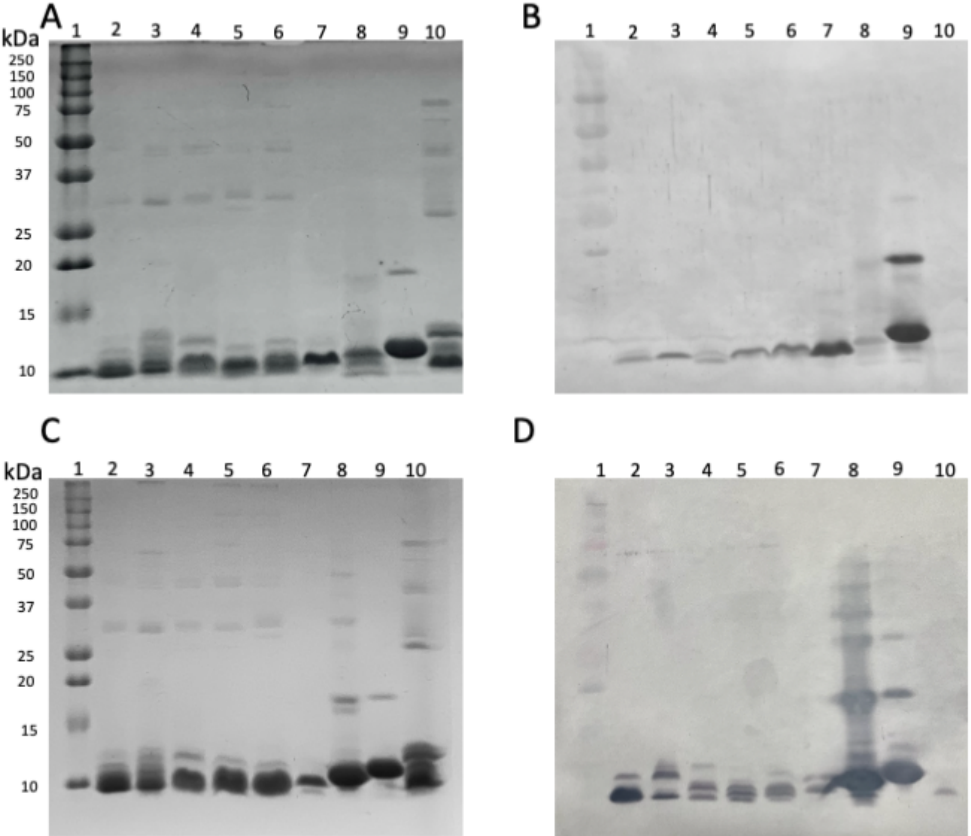
Figure 4. Proteins contained in venoms from different species of North Africa and the Middle East scorpion venoms were detected by SDS-PAGE and Western-blot. (A) SDS-PAGE 12.5%, (B) Western blot anti-HisrAcra4, (C) SDS-PAGE 12.5%, (D) Western blot anti-Scctx. Lanes: 1 – PM, 2 – A. crassicauda, 3 – A. australis hector , 4 – A. mauritanicus, 5 – L. quinquestriatus hebraeus. 6 – B. occitanus, 7 – native AaH2, 8 – HisrAcra4, 9 – HisrSccTx, 10 – T. pachyurus. (A) The SDS-Gel had 50 µg per well, and the Western-blot had 10 µg per line (first antibody: rabbit IgG anti-mixture of recombinants HisrSccTx; second antibody: rabbit IgG combined to alkaline phosphatase).